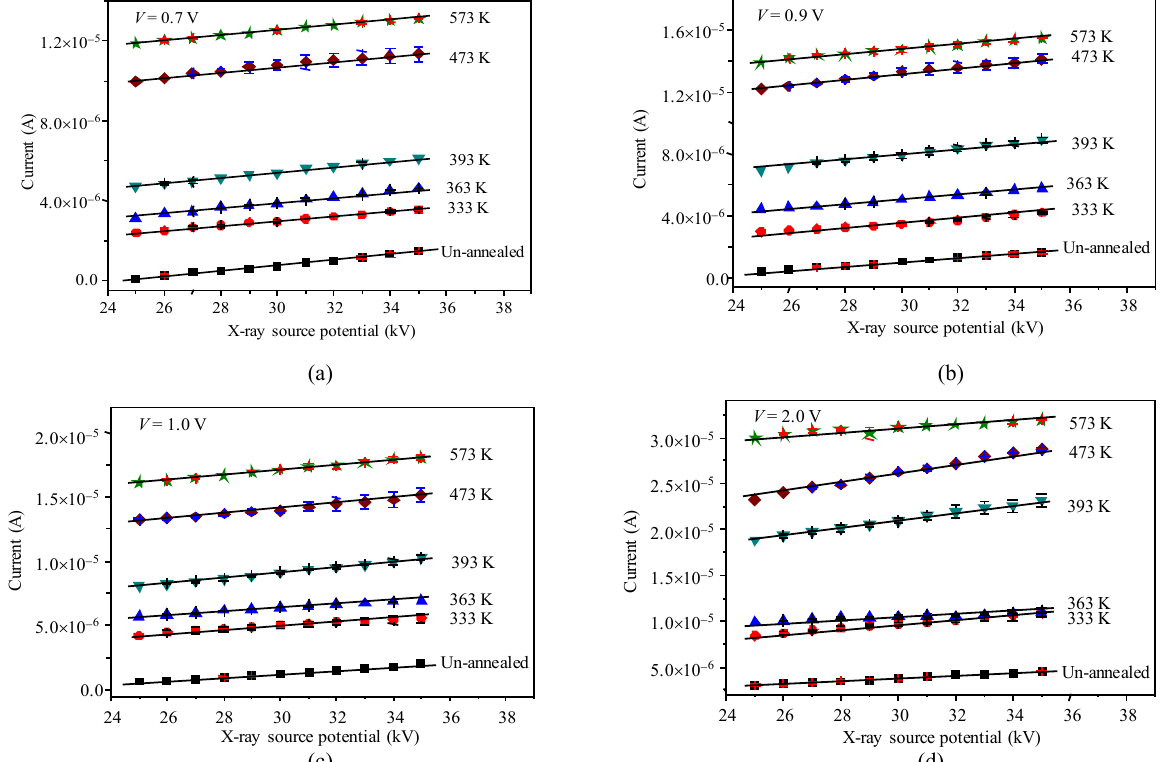
Fig. 6 Variation of current with X-ray source potential for the un-annealed and 333 K, 363 K, 393 K, 473 K, and 573 K annealed films corresponding to bias voltage: (a) V = 0.7 V, (b) V = 0.9 V, (c) V = 1.0 V, and (d) V = 2.0